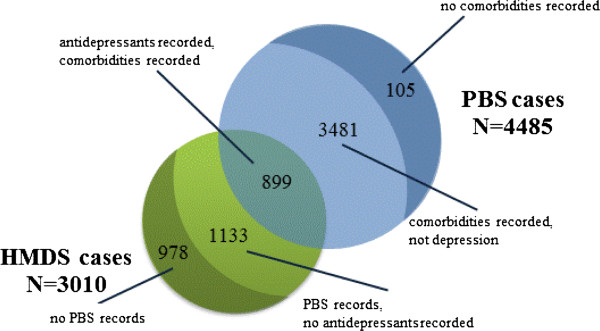
Ascertainment of cases by dataset, N = 6596 pregnancies.